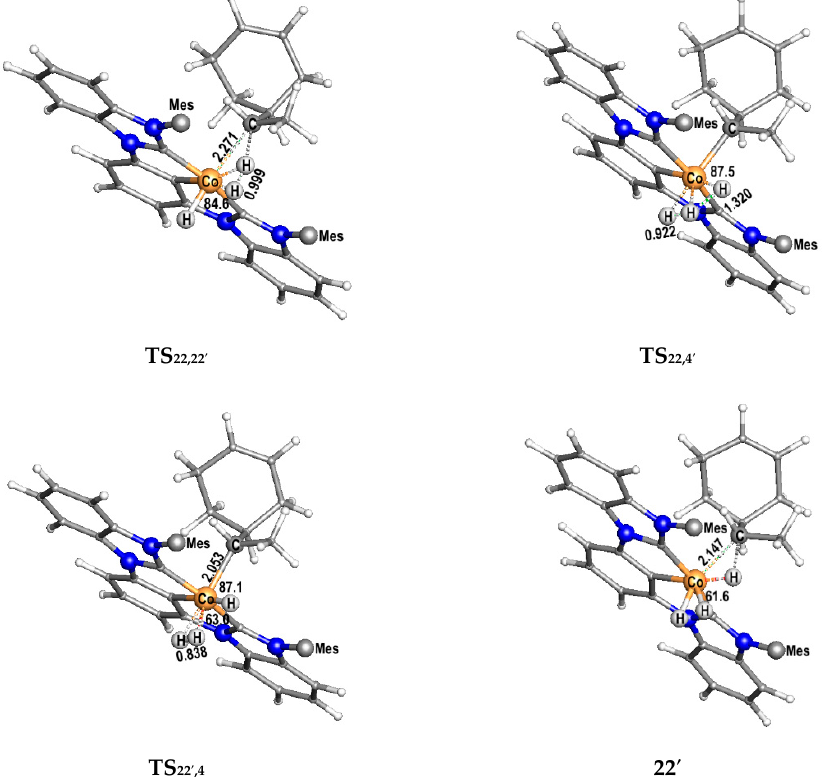
Figure 10. Optimized structures of TS 22,4 ′ (927 i cm − 1 ), TS 22,22 ′ (502 i cm − 1 ), 22 ′ , and TS 22 ′ ,4 (775 i cm − 1 ). Mesitylene groups are omitted for clarity. Bond lengths are in Å, and bond angles are in °.